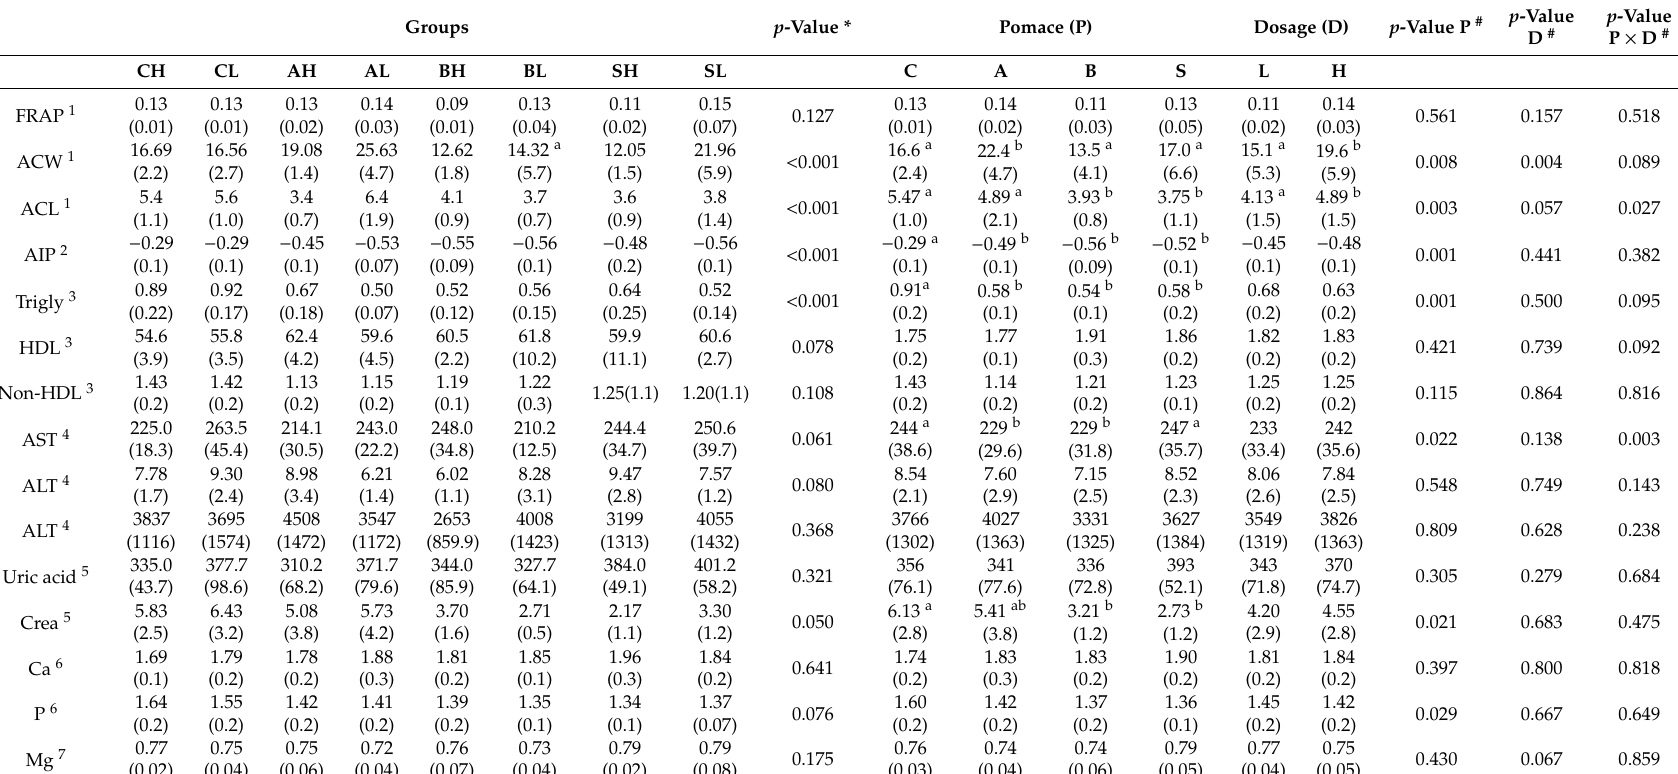
Table 4. Serum antioxidant parameters, serum lipids and minerals and renal and liver function.